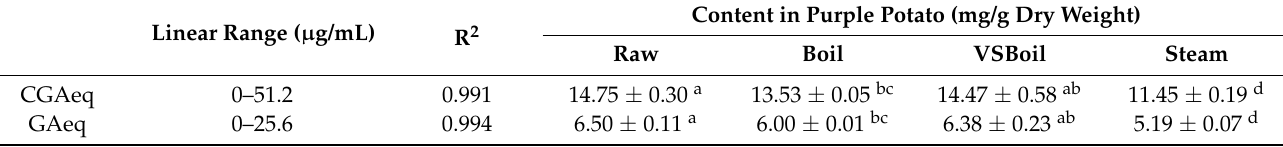
Table 1. Total polyphenolic content in purple potato after different cooking